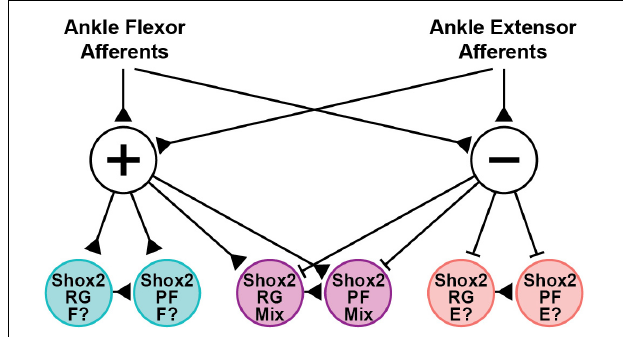
FIGURE 8 | Hypothesized structure of afferent pathways synapsing on Shox2 neurons in the neonate. Ankle flexor-related afferents from the CPn and extensor-related afferents from the Tn synapse on both excitatory (+) and inhibitory ( − ) interneuron populations. The interposed excitatory interneurons subsequently synapse on three sets of Shox2 RG and Shox2 PF populations that receive excitatory, inhibitory or mixed inputs. Pathways are depicted disynaptically but may be oligosynaptic. This connectivity structure is proposed on the basis of data collected in the quiescent context, but is consistent with the observed flexor-biased modulation of ongoing locomotion at P1-P3 by activation of CPn and Tn afferents. Together, this suggests that the Shox2 population receiving excitatory inputs (teal) may be flexor-related (F?), while the Shox2 population receiving inhibitory inputs (pink) may be extensor-related (E?). Developmental changes in connectivity either by pruning or by context-dependent activation of gating circuits are expected to occur at the level of the interposed interneurons. Production of connectivity structures in which flexor- and extensor-related Shox2 neurons receive excitatory inputs from homonymous afferents and inhibitory inputs from antagonist afferents, as suggested by studies in the rat and cat, can be more easily explained by pruning or gating if the interposed neurons targeted by CPn and Tn afferents are distinct from one another (not